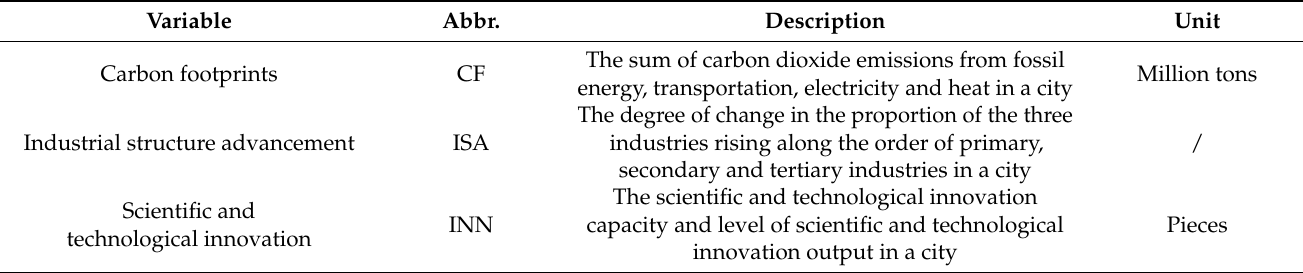
Table source: authors’ own